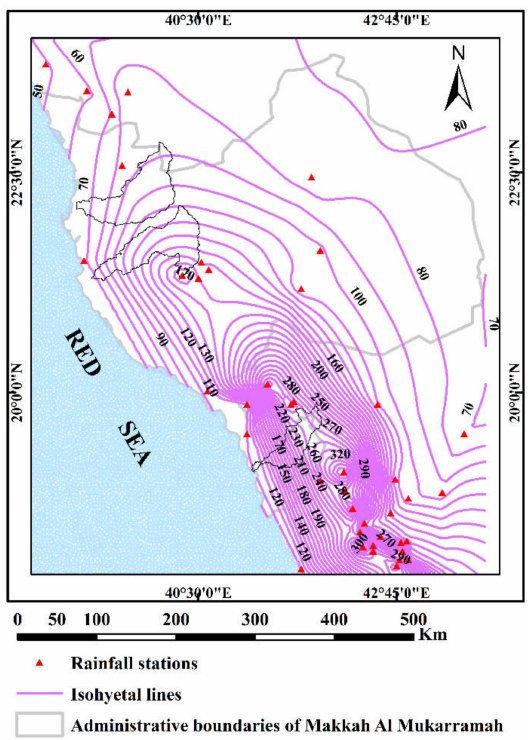
Figure 3. Annual distribution map of average rainfall (mm) in Makkah Al-Mukarramah Province, Saudi Arabia